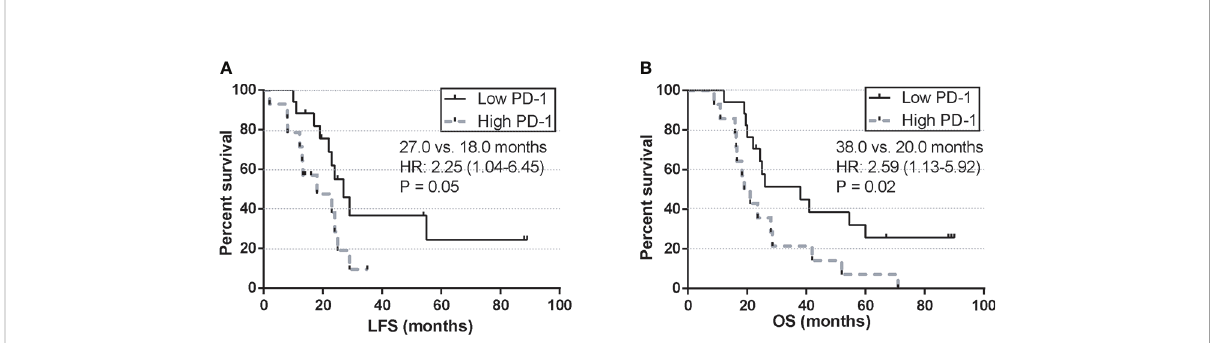
FIGURE 5 Univariate survival analysis of LFS and OS by the post-treatment PD-1 expression. (A) LFS by PD-1 expression at C2 in MDS patients treated with HMA. (B) OS by PD-1 expression at C2 in MDS patients treated with HMA.